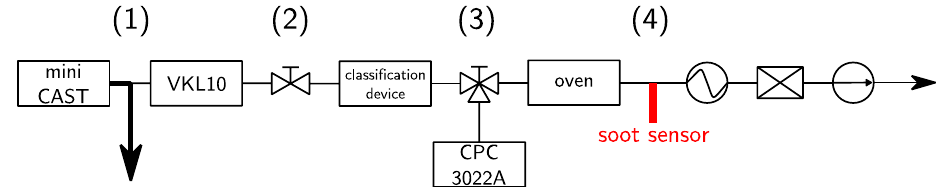
Figure 1. Schematic view of the experimental bench. A CPC 3022A, TSI (Condensation Particle Counter) has been used to measure the distribution size function of the soot aerosol.